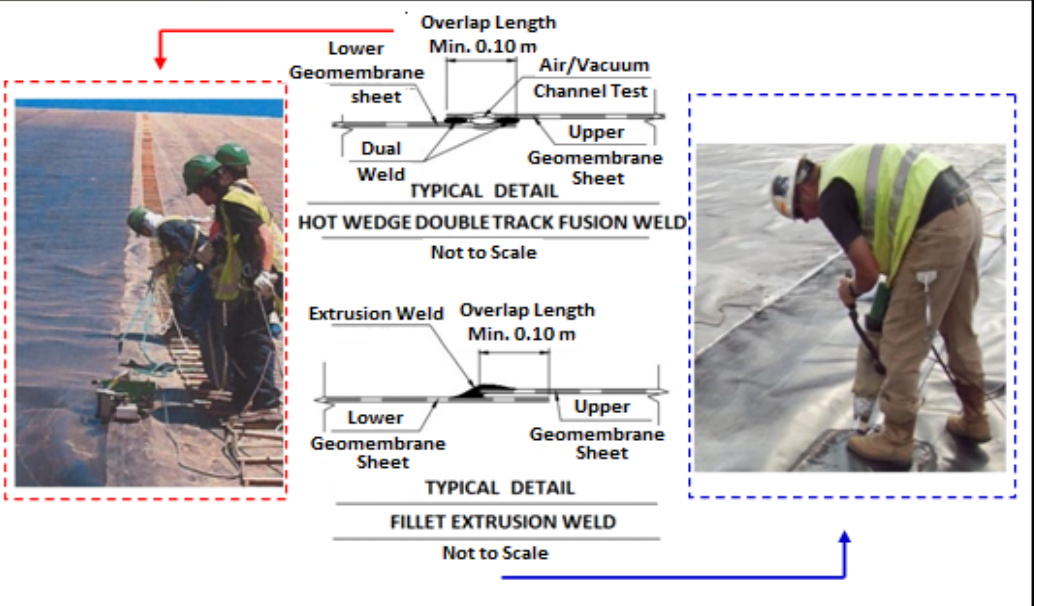
Figure 14. Geomembrane seams—typical details.